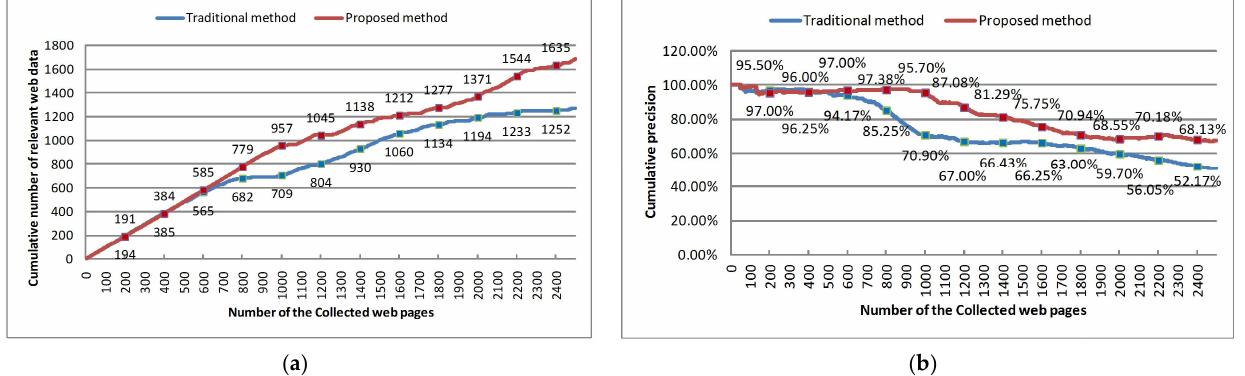
Figure 4. Crawling results of the two methods. ( a ) is the cumulative number of relevant web pages. ( b ) is cumulative precision.